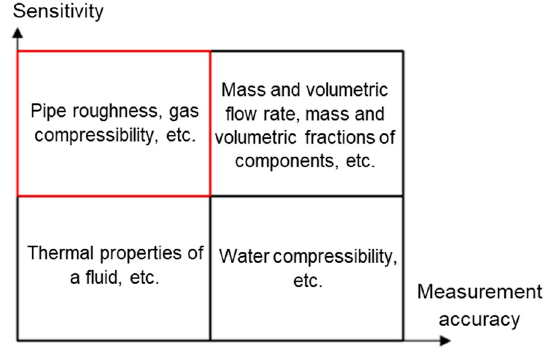
Figure 1. Simulator parameters grouped by the two criteria.